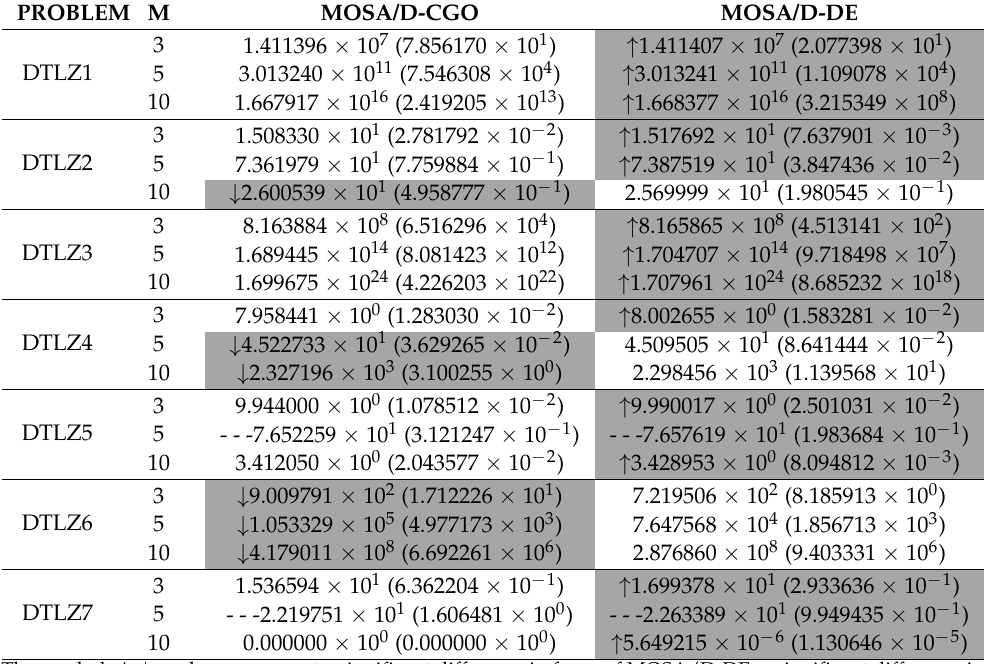
Table 6. Means and standard deviation of HV results of 42 instances.